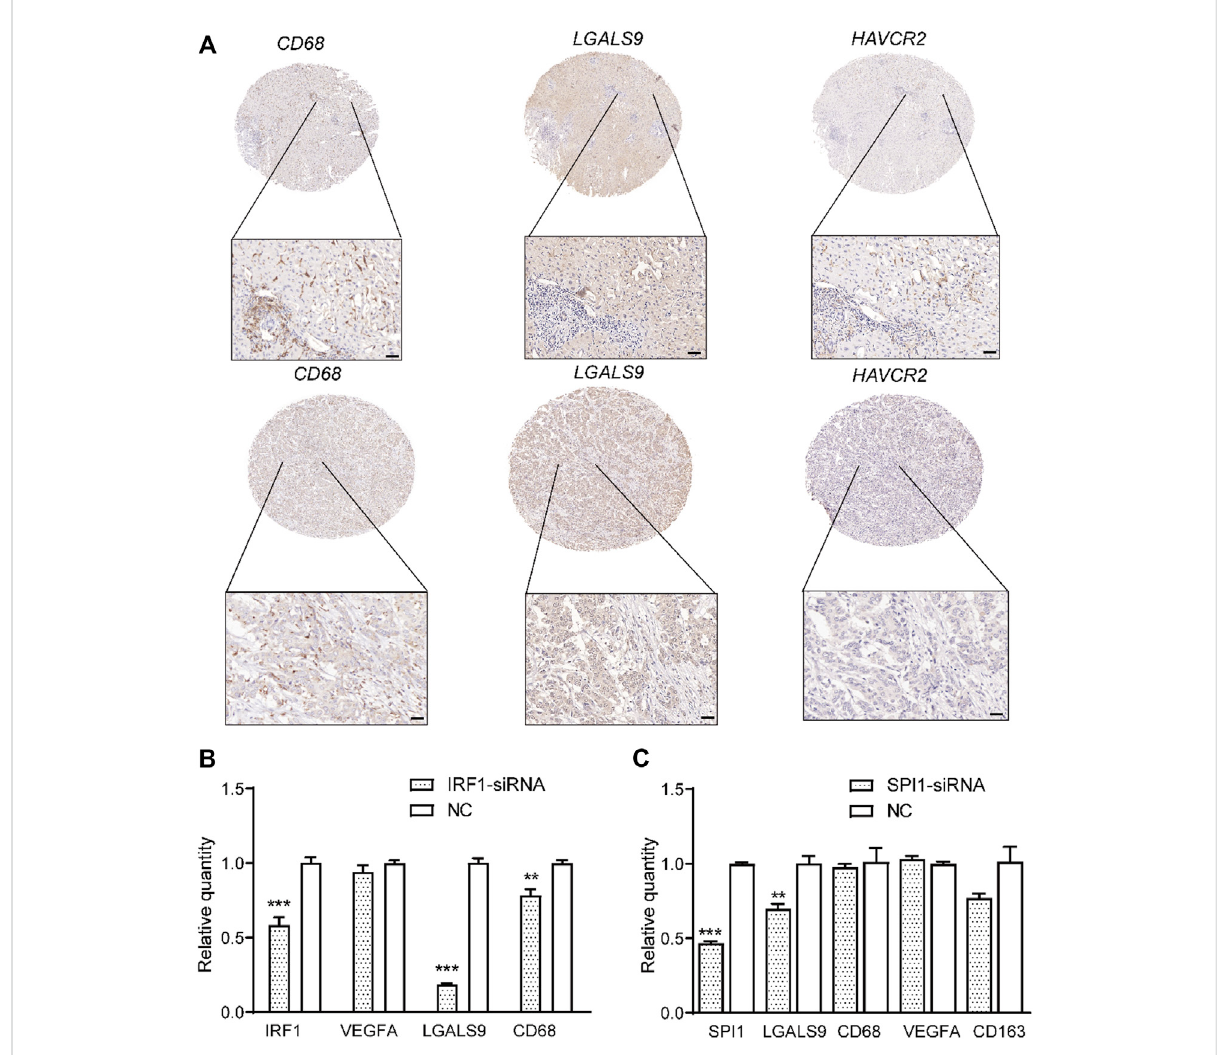
FIGURE 3 Validationofco-expression of LGALS9 and HAVCR2 andfunctionoftranscriptionfactors IRF1/SPI1 . (A) Immunohistochemical plotshowingthe co-expression of LGALS9 and HAVCR2 in two CCA patients. Scale bars represent 50 μ m. Bar plot showing that TFs IRF1 (B) and SPI1 (C) could regulate the expression level of LGALS9 (*** p < 0.001; ** p < 0.01, t